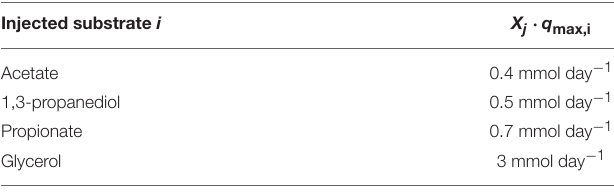
TABLE 2 | Estimated maximal rates of substrate consumption directly after the concentration pulse, assuming c i >> K S,i using Equation 4. Injected substrate